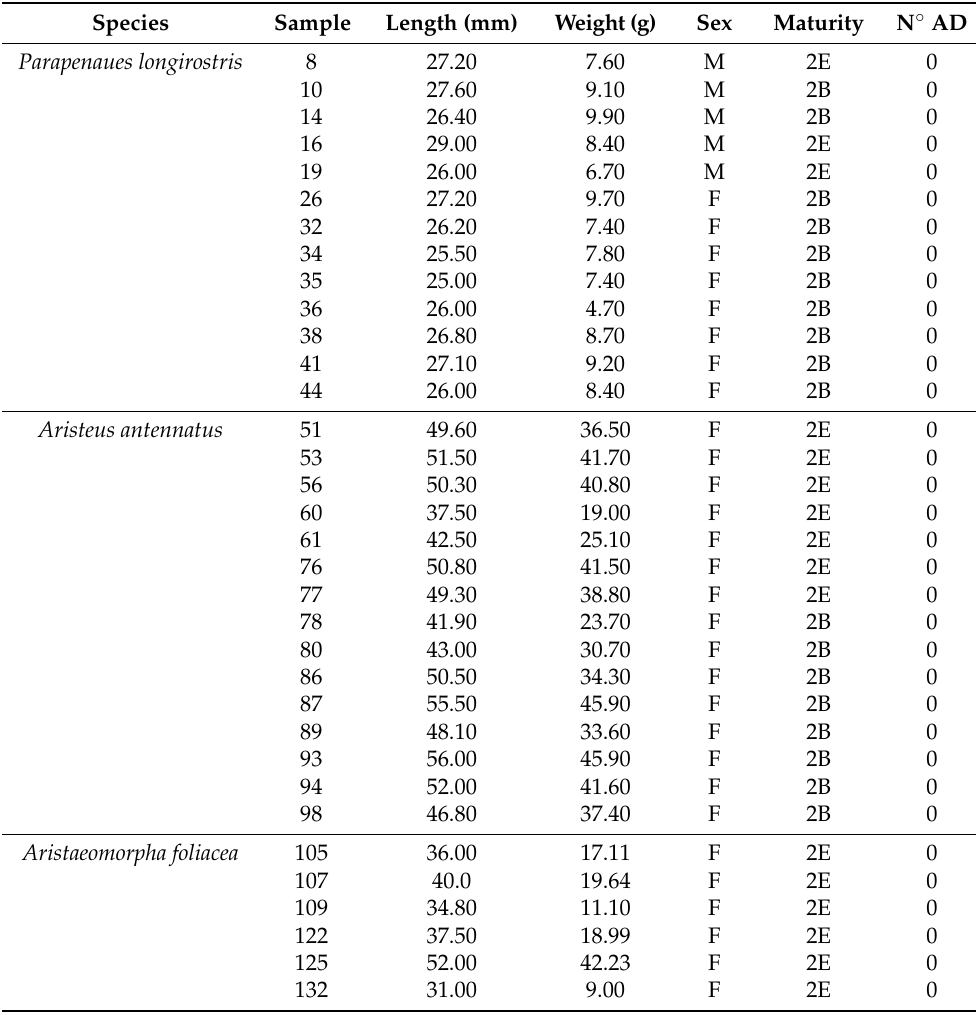
Table 2. Morphometric data of the analyzed crustacean species collected from the south-western Ionian Sea that did not show anthropogenic particles contamination. Maturity stages (see Maturity column) were detected according to the Atlas of the maturity stages of Mediterranean fishery re- sources [65]; 2E represents the resting adults stage in female specimens (uncolored resting ovaries with the presence of spermatophores in A. antennatus and A. foliacea ) and 2B represents the recovering stage in both female (ovary developing status with a flesh, ivory and cream color in A. foliace, A. an- tennatus and P. longirostris, respectively) and male specimens (petasma completely joined, without spermatic masses in the seminar